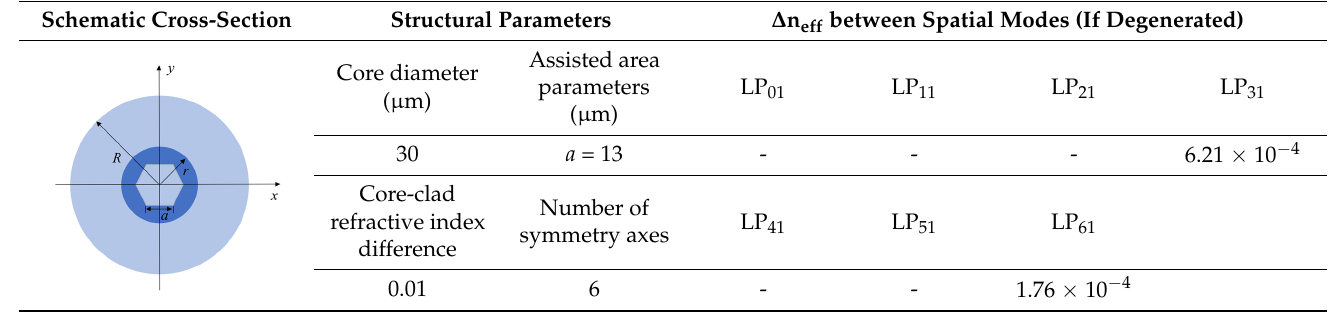
Table 4. Mode properties when the central-assisted area is a concave polygon (at the wavelength of 1550 nm).